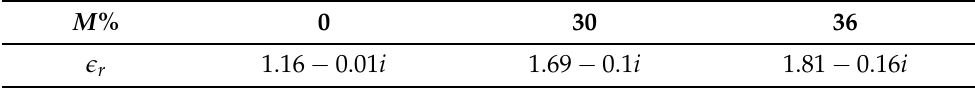
Figure 4. 3-D MWT setup used in this study to generate synthetic measurement data. Table 2. Permittivity of the foam with different moisture contents M on wet